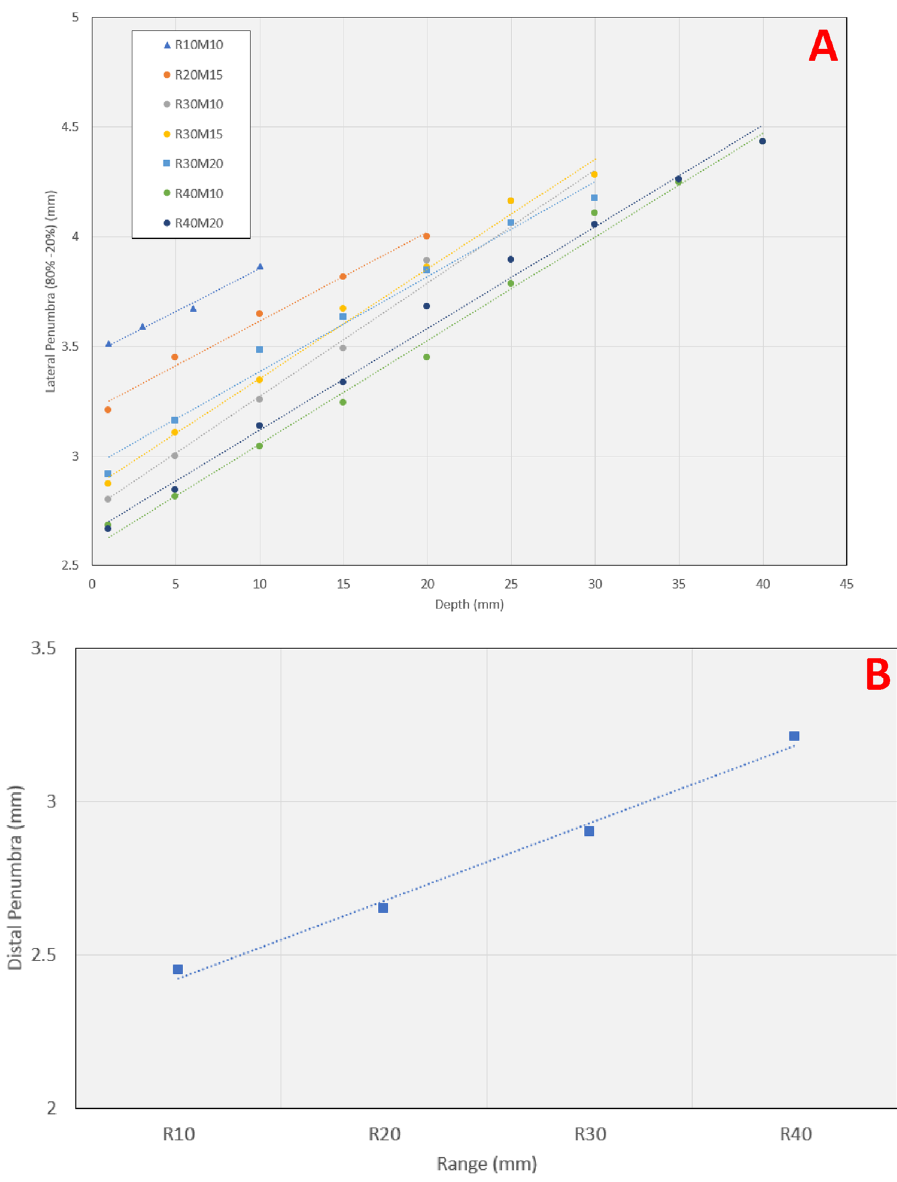
Figure 8. Variation in the ( A ) lateral penumbra with depth for seven beams simulated with various range- modulation combinations ( B ) distal penumbra as a function of the proton beam range. The actual measurement points correspond to marker locations, linear trendlines are shown for visualization